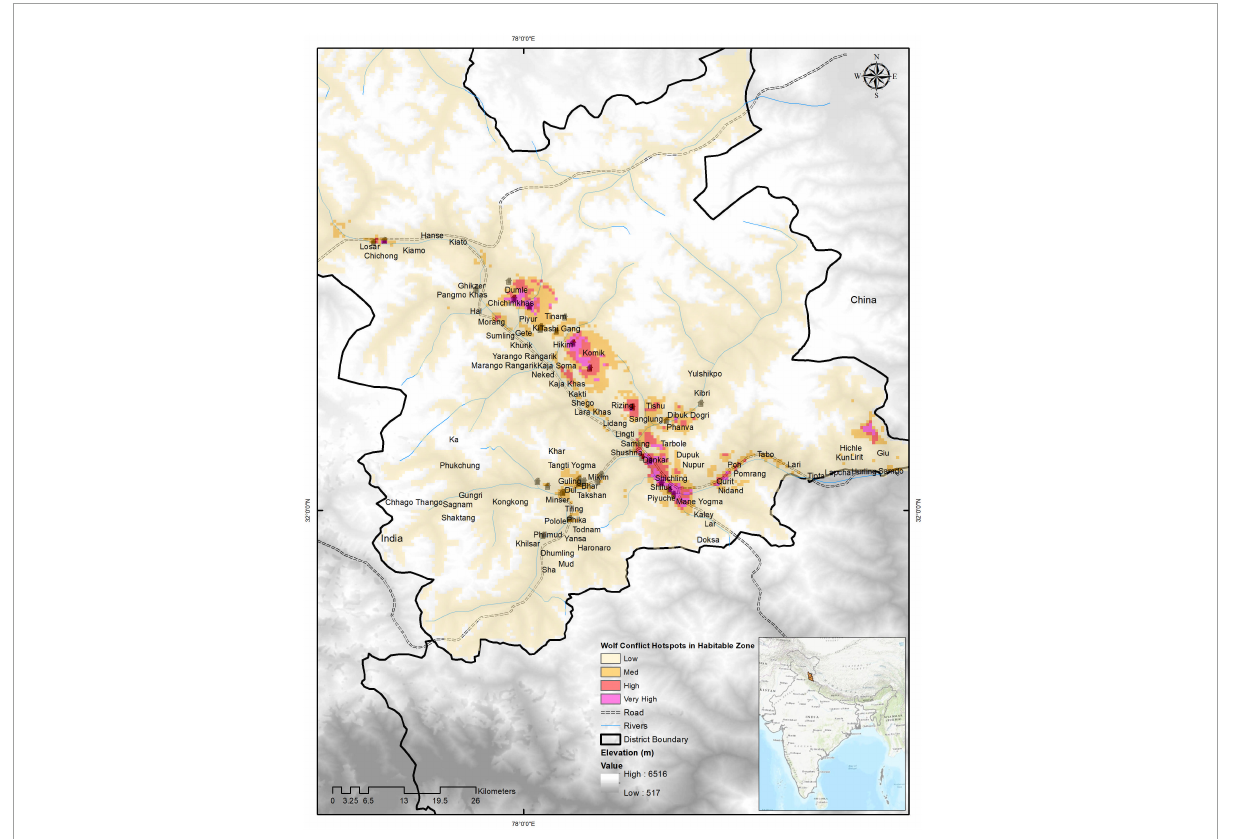
FIGURE5 Wolf conflict hotspots modeled showing darker pink regions with higher conflicting potential. The very high conflict zone is 36 km 2 , the high conflict zone is 62 km 2 , the low conflict zone is 196 km 2 , and the low conflict zone below the threshold was 3,686 km 2 of the habitable study